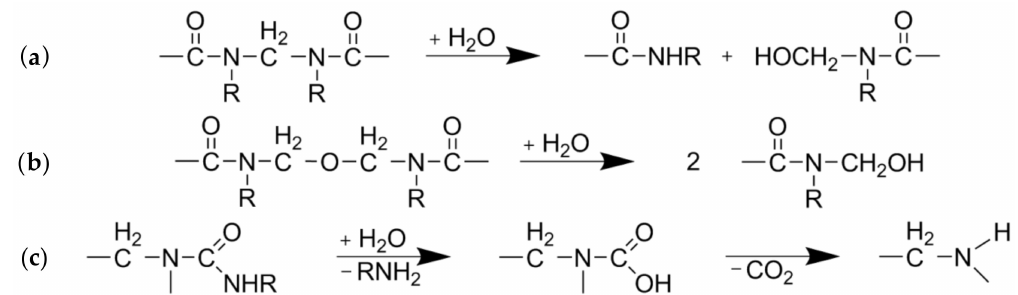
Figure 2. Degradation pathways of urea-formaldehyde (UF)-resin polymers: Cleavage of ( a ) methylene or ( b ) methylene-ether bridges and ( c ) separation of an amine [19].